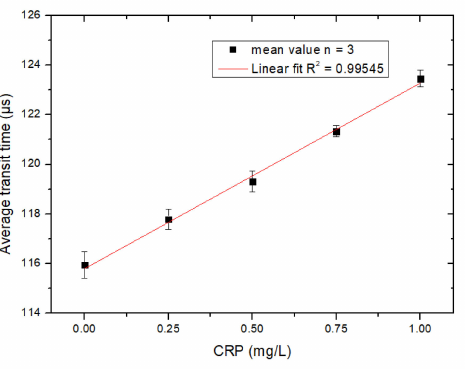
Figure 5. The relationship between the average transit time and CRP detected by the MCIA. Phosphate buffered saline (PBS) was used as the negative control. Each square and error bar were the mean value and standard deviation, respectively, of three parallel